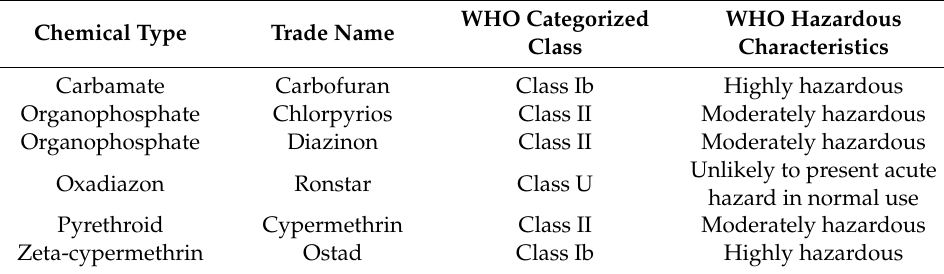
Table 2. Types of pesticides used by farmers in Matlab study area,